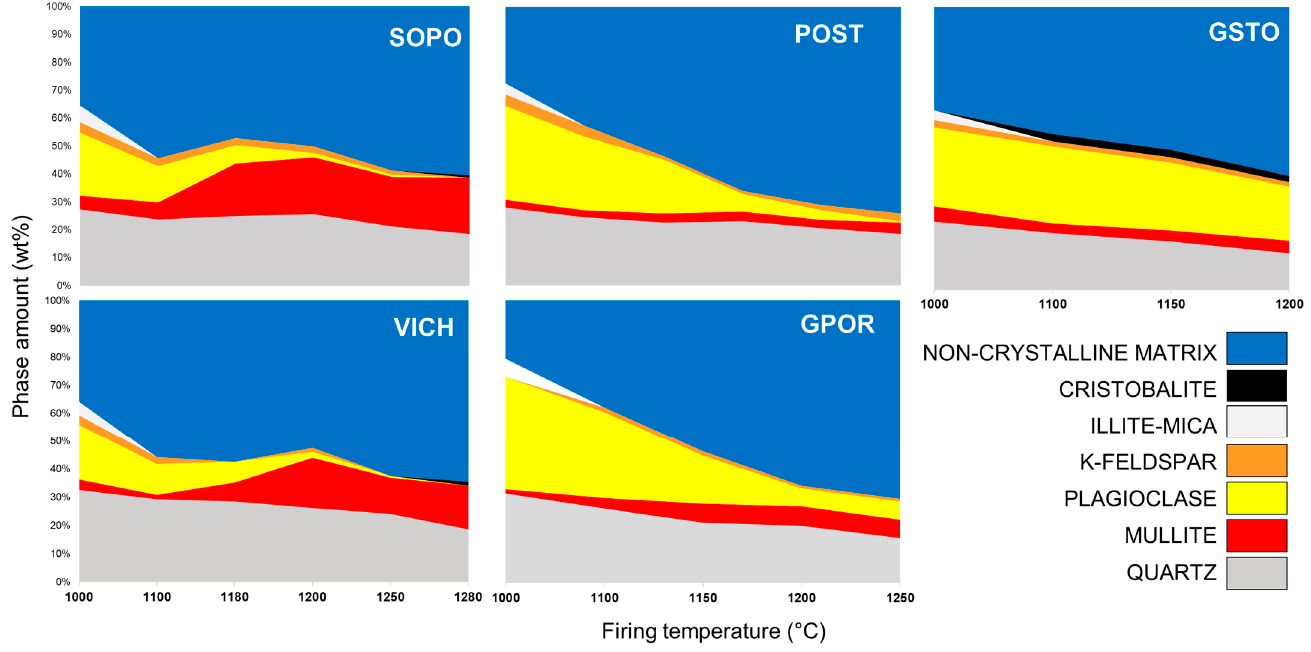
Figure 4. Mineralogical phase composition as a function of firing temperature.